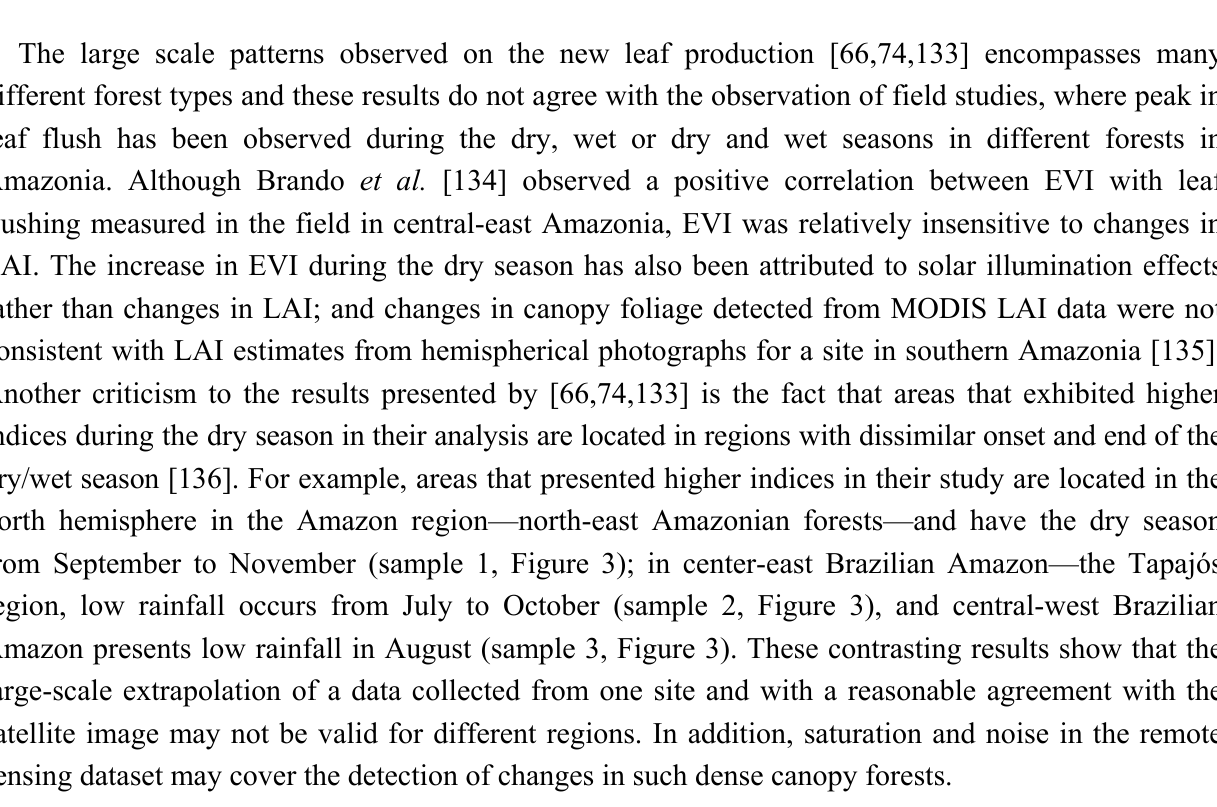
Figure 3. Rainfall derived from TRMM (Tropical Rainfall Measuring Mission), product 3B43-v6, at 0.25° spatial resolution. Dry season is defined here when rainfall is lower than the estimated tropical forests canopy transpiration (~100 mm·month − 1 ). ( a ) Location of the samples sites; ( b ) Averaged rainfall values for each sample, from 1998 to 2010, and the standard deviation as error